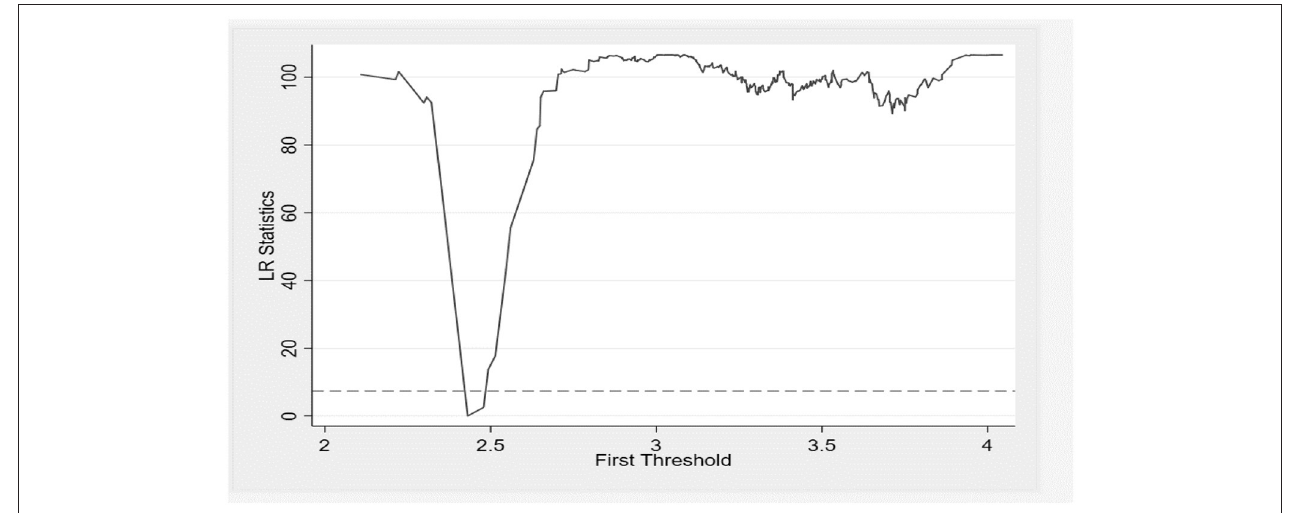
FIGURE 3 | Threshold effect.